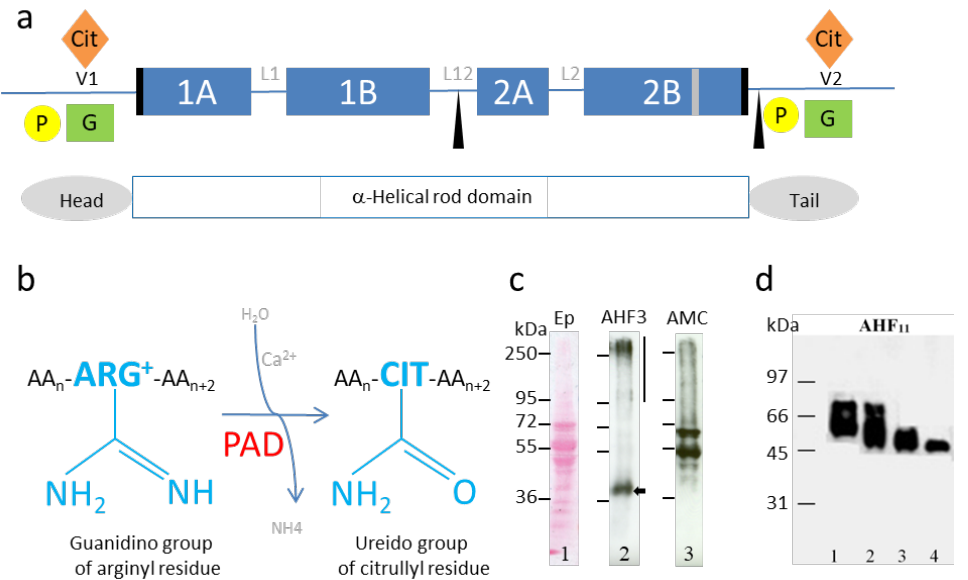
Figure 1. ( a ) Schematic representation of keratin structure, keratin major post-translational modifications and deamination reaction. P, phosphorylation, yellow dots; G, O-GlcNAcylation, green squares; Cit, citrullination or deimination, orange diamonds. Blue rectangles, 1A, 1B, 2A, 2B helicoidal domains constituting the α -helix rod domain; black boxes, helix initiation and termination motifs (Type I keratins do not contain any helix termination motifs); black triangles, caspase cleavage sites in Type I keratins; grey box, stutter region, variable amino-acid region inducing an imperfect coiled-coil arrangement [37]. L1, L12, L2, non-helicoidal linkers; Head and Tail, non-helicoidal terminal domains; V1 / V2, domains highly variable in size. ( b ) Schematic representation of the irreversible reaction of deimination (or citrullination). AA, amino acid; Arg, arginine; Cit, citrulline (unconventional amino acid not encoded by a tRNA). ( c ) Deiminated epidermal keratins and filaggrin. Lane 1, Ponceau staining of a total protein extract of a human reconstructed epidermis. Note the keratin migration between 50 and 70 kDa, as expected. Lane 2, immunodetection of human (pro)filaggrin with the AHF3 specific monoclonal antibody [38], (filaggrin monomer, black arrow; filaggrin precursor, profilaggrin, black vertical line). Lane 3, deiminated proteins immunodetected with the anti-modified citrulline specific AMC antibody [17]. ( d ) Human recombinant His-Filaggrin deiminated by recombinant human PAD1, -2 or -3 (Lanes 1–3, respectively) or non-deiminated (control, Lane 4), as previously described [39]. A huge di ff erential shift can be observed in the migration between the non-modified (Lane 4) and the deiminated (Lane 1–3) filaggrin. Filaggrin was immunodetected with AHF11 monoclonal antibody as previously described